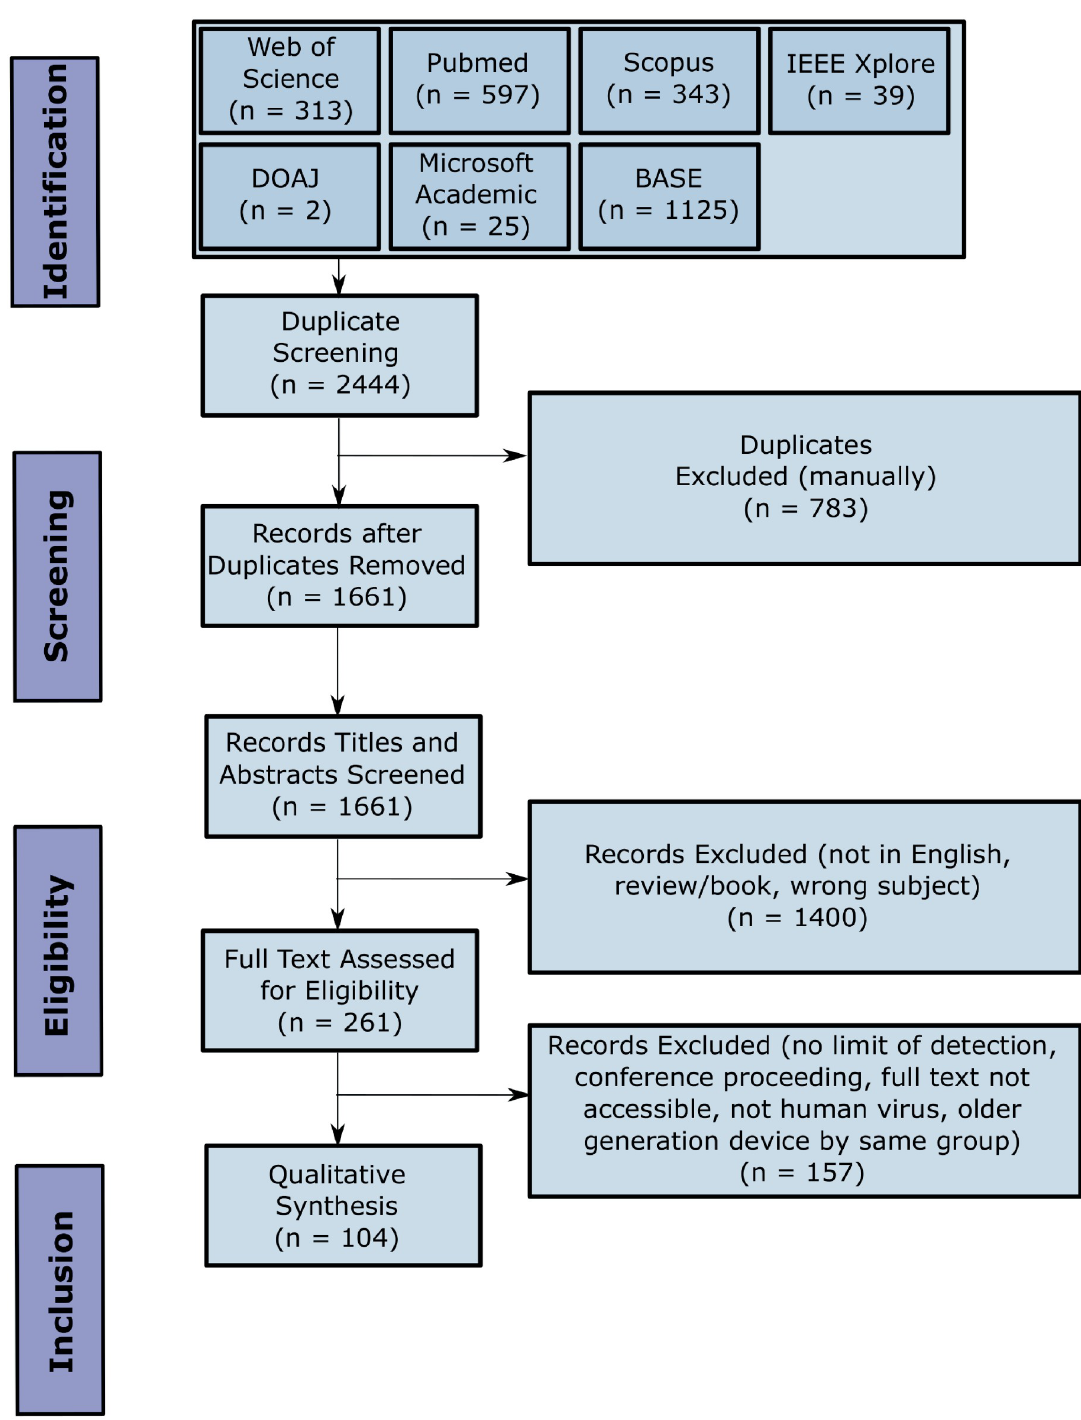
Fig 1. PRISMA flowchart. PRISMA flowchart detailing the systematic review process.